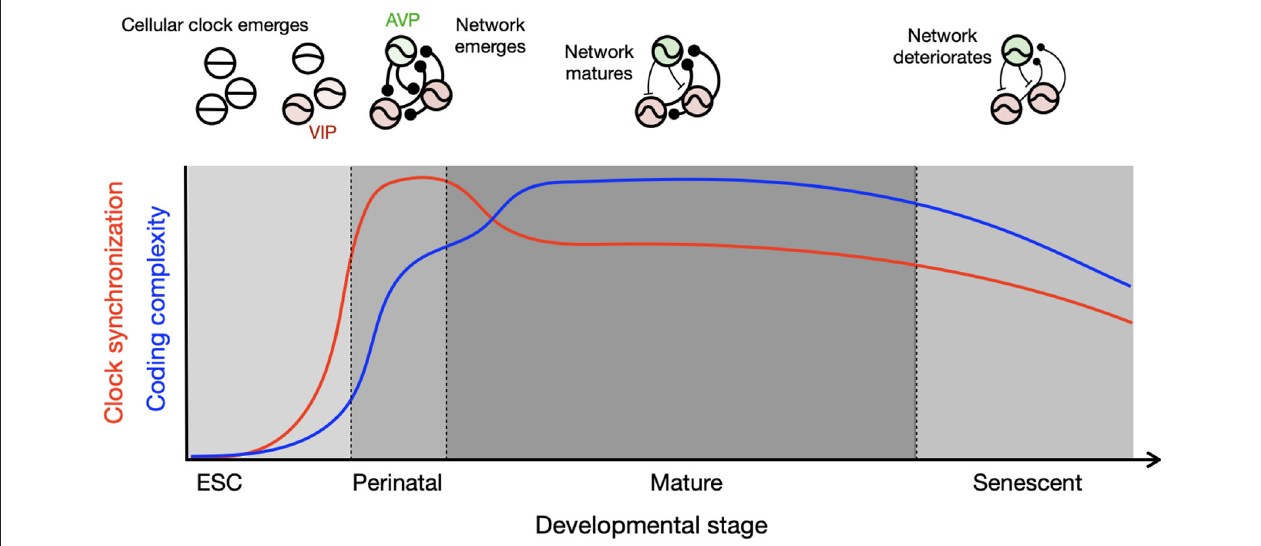
FIGURE 1 | Development of cellular and network circadian clocks characterized by clock synchronization and complexity. Single-cell molecular clocks and their inter-cellular network evolve together through the course of development, which results in divergent parallel development of synchronization (red) and complexity (blue). The circadian clock emerges in single cells after embryonic stem cell (ESC) stage and connections are made in single positive polarity (round ending) in the perinatal stage pushed by homogeneously excitatory GABA and high expression of GR, resulting in strong synchronization among the clock cells. Diversity in neuropeptidergic expression and mixture of excitatory and inhibitory GABA (T-shaped ending) develop toward maturation, which slightly lowers the degree of synchronization but allows for complexity by a wider distribution of clock phases as found during seasonal time encoding. The schematics in the upper panel illustrate oscillatory properties of single cells and network coupling for each developmental stage, with thicker connection line indicating stronger